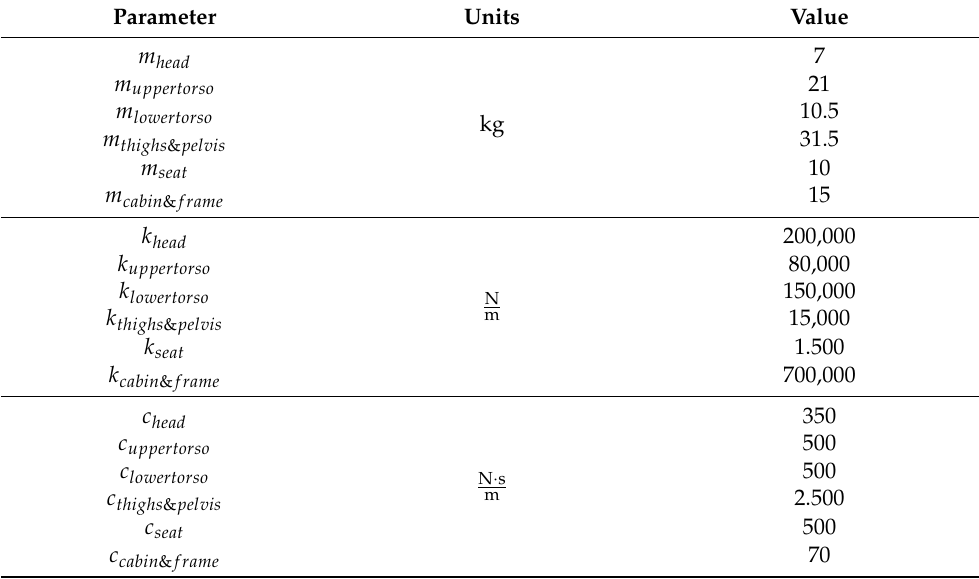
Table 5. Values of the parameters of the seat and human model in the eight DOFs VSH model. Parameter